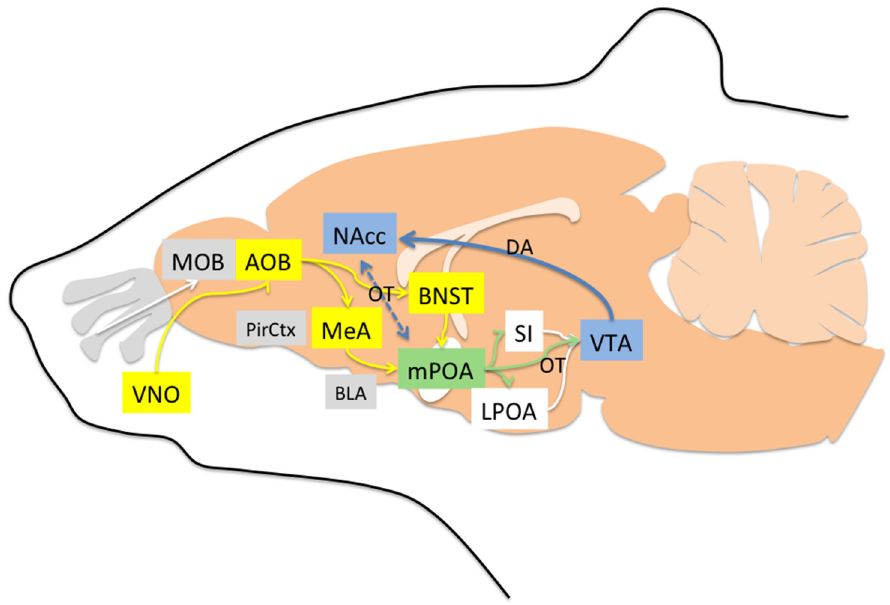
Figure 1. Sagittal drawing of brain olfactory pathways involved in acceptance, offspring social recognition, care motivation, and inhibition of rejection. Nonvolatile odor molecules are processed by the accessory pathway (yellow) via the vomeronasal organ (VNO), accessory olfactory bulb (AOB), bed nucleus of the stria terminalis (BNST), medial amygdala (MeA), and medial preoptic area (mPOA, green). The mPOA projects to the lateral preoptic area (LPOA), substantia innominata (SI), and ventral tegmental area (VTA, blue), which sends dopaminergic projections to the nucleus accumbens (NAcc, blue). Volatile odor molecules are processed by the main (gray) olfactory epithelium (MOE), main olfactory bulb (MOB), and piriform cortex (PirCtx), and from there to the NAcc and mPOA (which interact via oxytocin “OT” and dopamine “DA”). The basolateral (BLA) amygdala and prefrontal cortex (not shown) participate in rejection and fear.